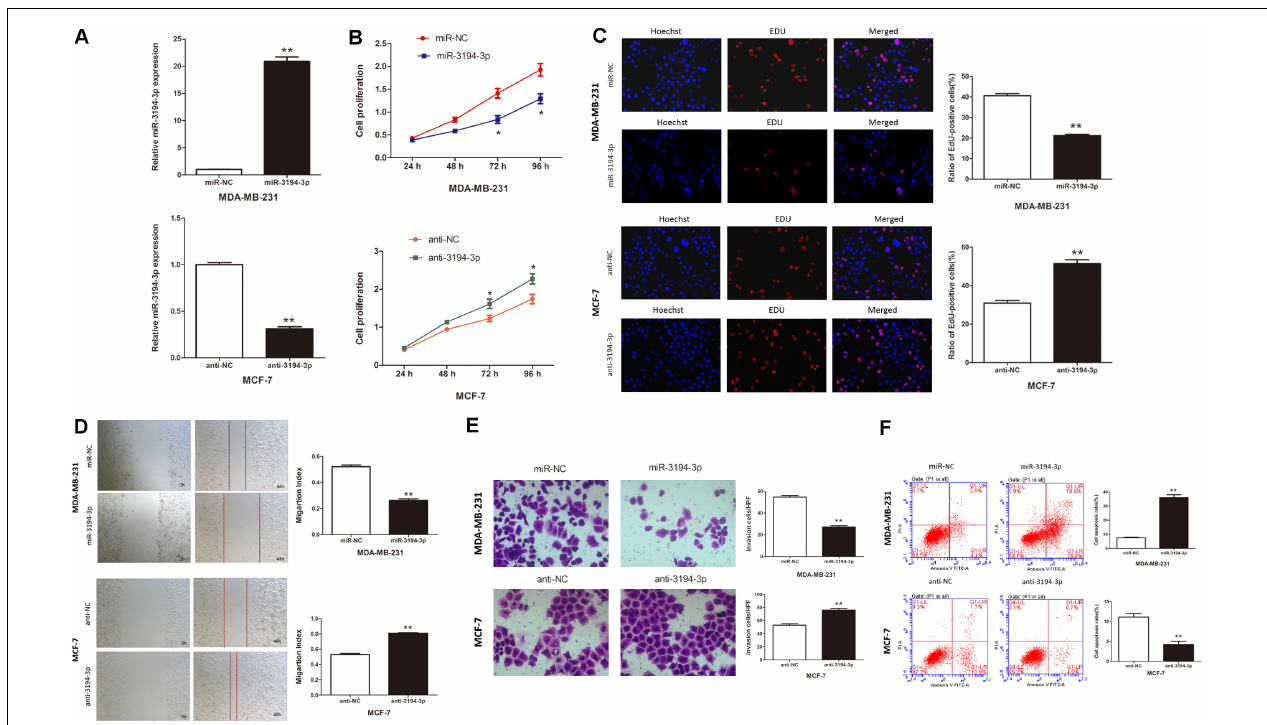
FIGURE 2 | miR-3194-3p expression regulates cell proliferation, migration, invasion, and apoptosis in BC. (A) miR-3194-3p expression was measured by qRT-PCR in MDA-MB-231 and MCF-7 cells transfected with miR-3194-3p mimic/inhibitor and their negative controls. Cell proliferation was assessed with (B) CCK-8 assay and (C) Edu assay. (D) Cell migration was measured by wound-healing assay. (E) Cell invasion was measured by transwell assay. (F) Cell apoptosis was measured by Flow cytometry analysis (* P < 0.05 and ** P <